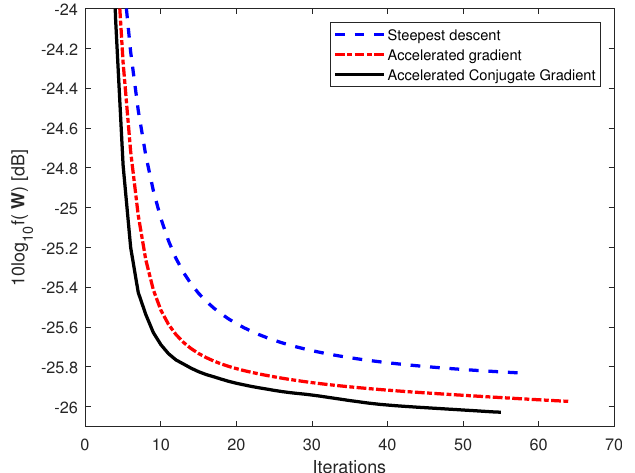
Figure 5. Convergence for real car recording data with three microphones and 10dB